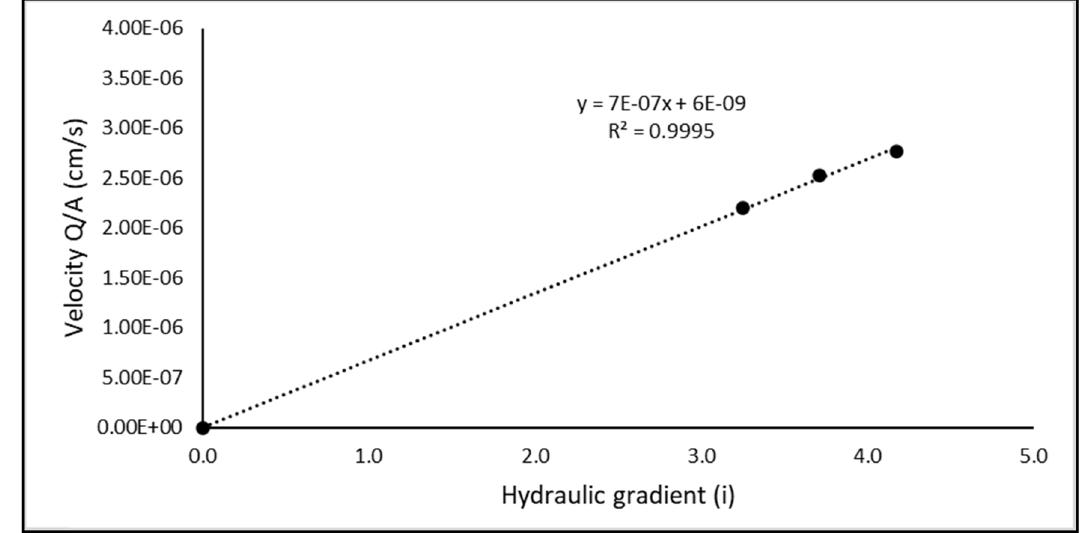
Figure 7: Viscosity – hydraulic gradient for a copper tailing - based